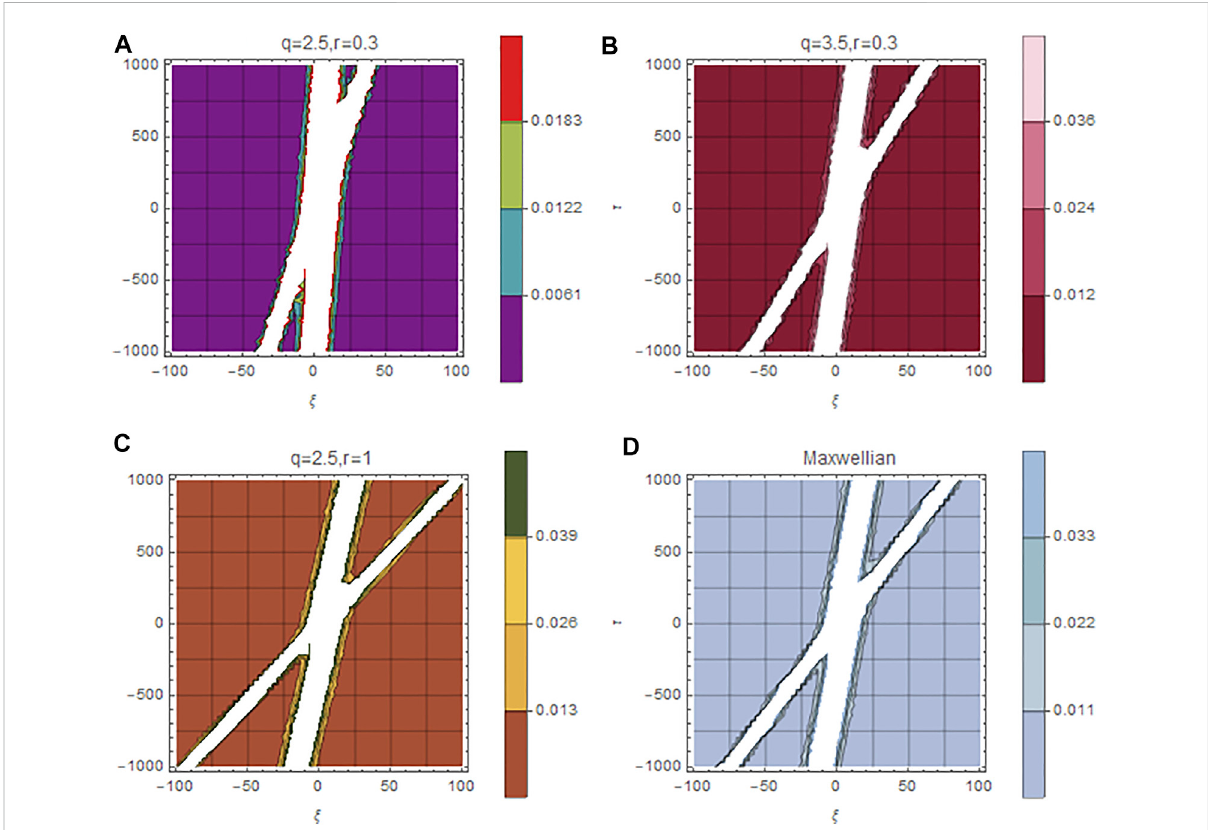
Variation of normalized electric potential Ψ ( ξ , τ ) of compressive two soliton solution is plotted against the normalized scale ξ by varying the spectral indices r and q and comparison with Maxwellian distribution. Here, n c 0 = 0.5 cm − 3 , n h 0 = 2 cm − 3 , n b 0 = 1 cm − 3 , σ c = 0.001, σ b = 0.01 and v b 0 =